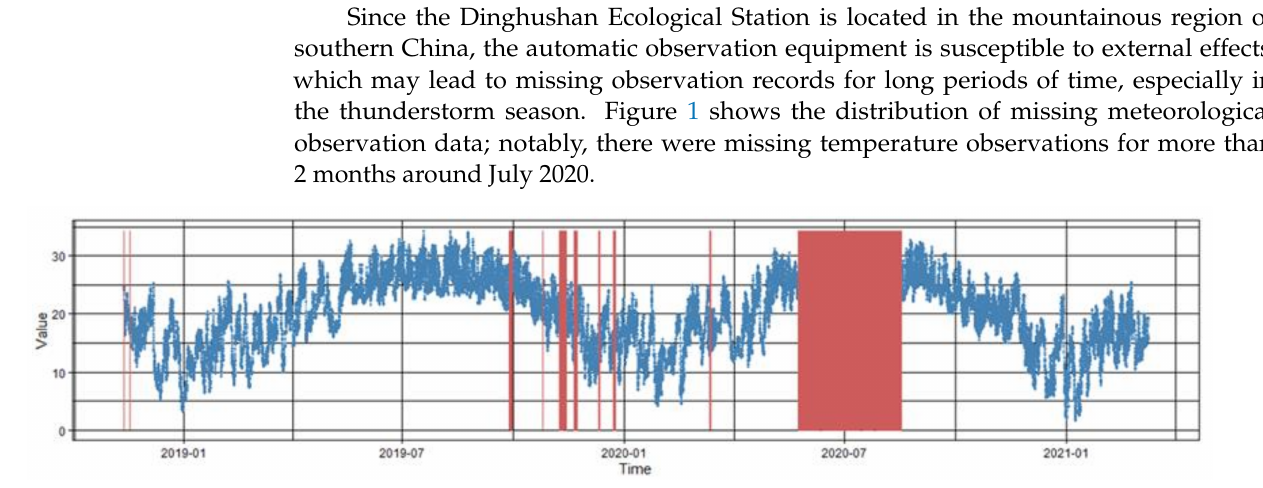
Figure 1. Distribution of missing values in half-hourly temperature observation